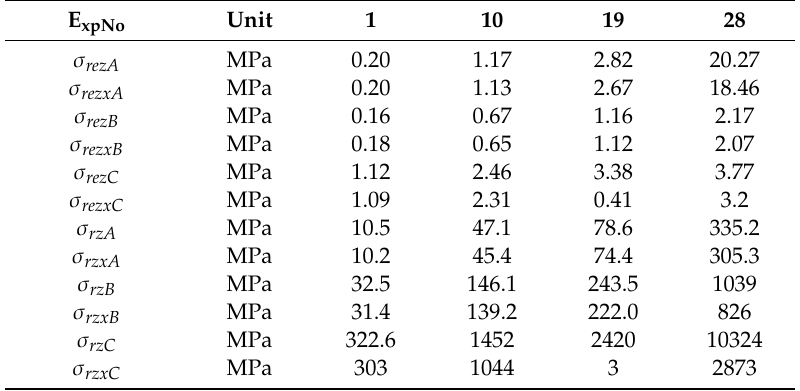
Figure 9. Comparison of working parameters LOG f ( W p ) = f ( E xpNO ) for EN S235JRG1, where: Section A ( E xpNO 1-6) insufficient roughness for the desired adhesion, Section B ( E xpNO 6-13) very good roughness for the desired adhesion, Section C ( E xpNO 13-24) sufficient roughness for the desired adhesion.